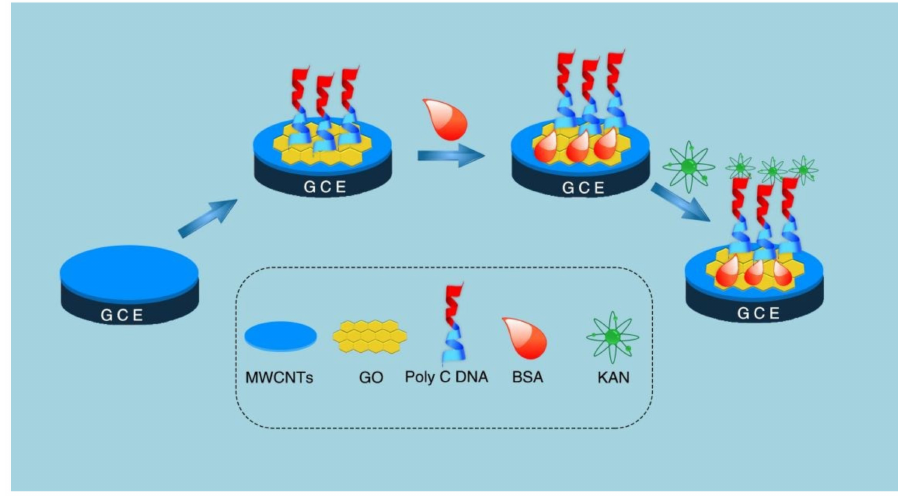
Figure 7. Schematic illustration of fabrication process for the DNA biosensor. Adapted with permis- sion from Ref. [80]. Copyright 2020 Royal Society of